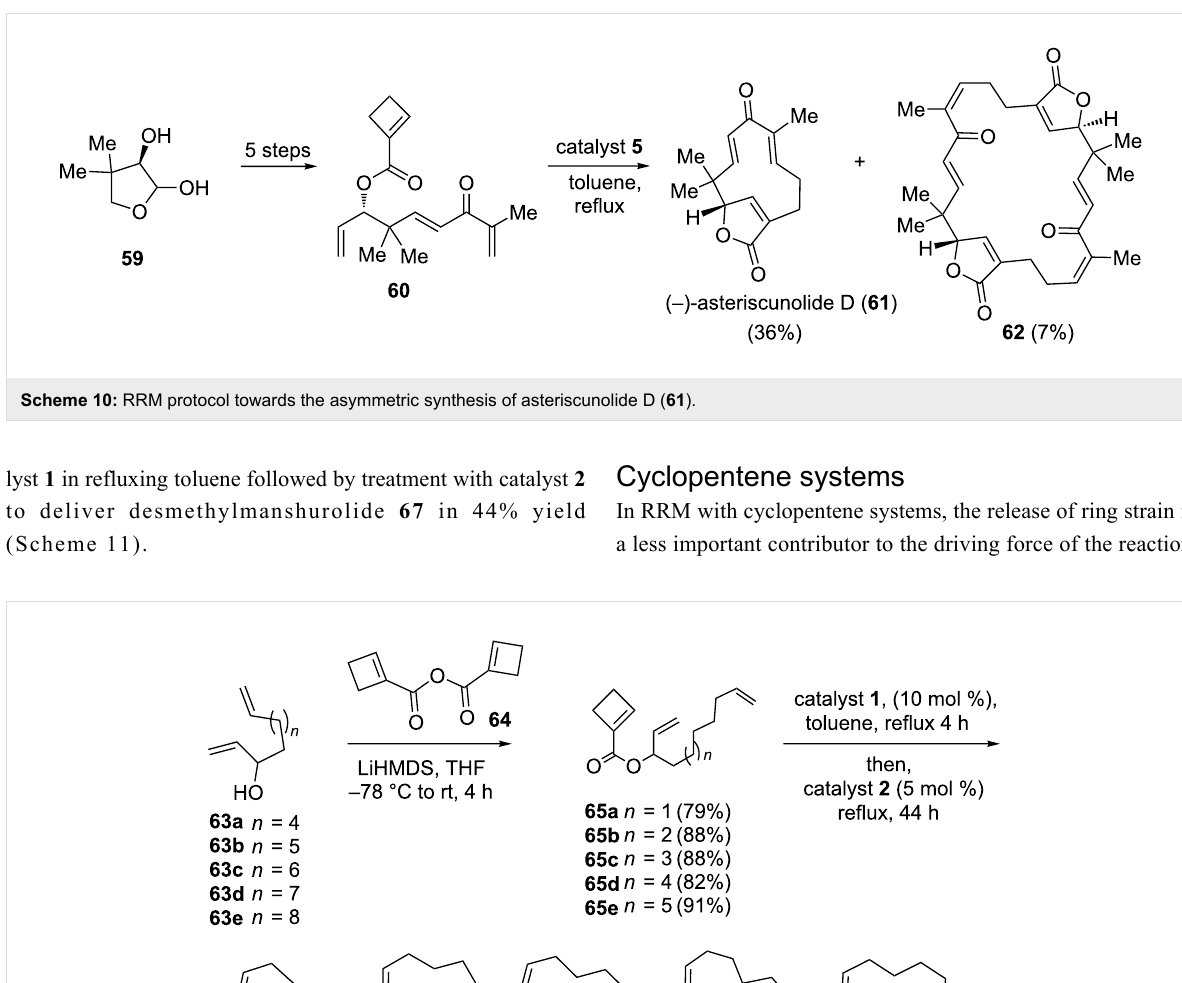
lyst 1 in refluxing toluene followed by treatment with catalyst 2 to deliver desmethylmanshurolide 67 in 44% yield (Scheme 11).